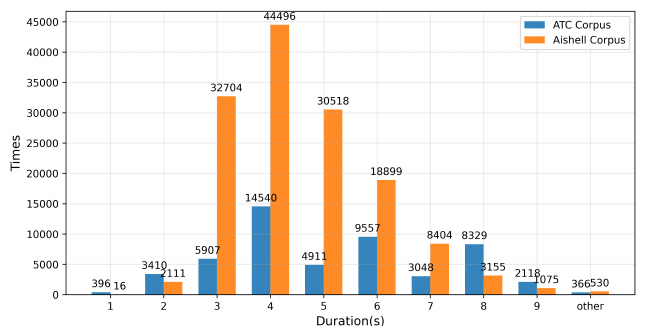
Figure 4. Duration distribution chart of two